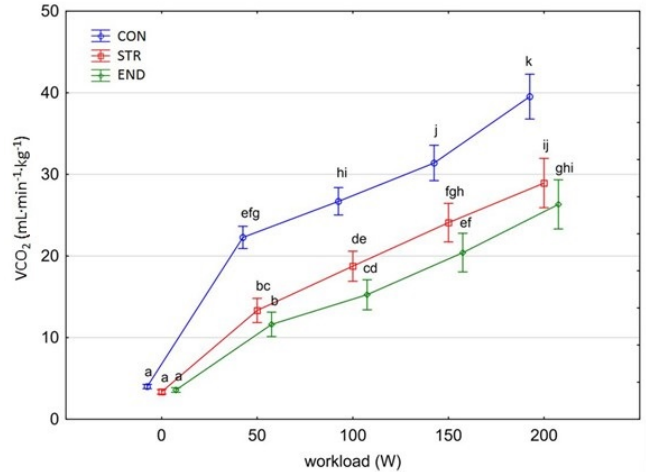
Figure 3. Carbon dioxide production (VCO 2 ) at rest and its response during the progressive exercise test; point and whiskers—mean ± 95% CI; the signs—a, b, c, d, e, f, g, h, i, j, k indicate homogeneous groups ( post-hoc Tukey’s HSD test: p > 0.05).